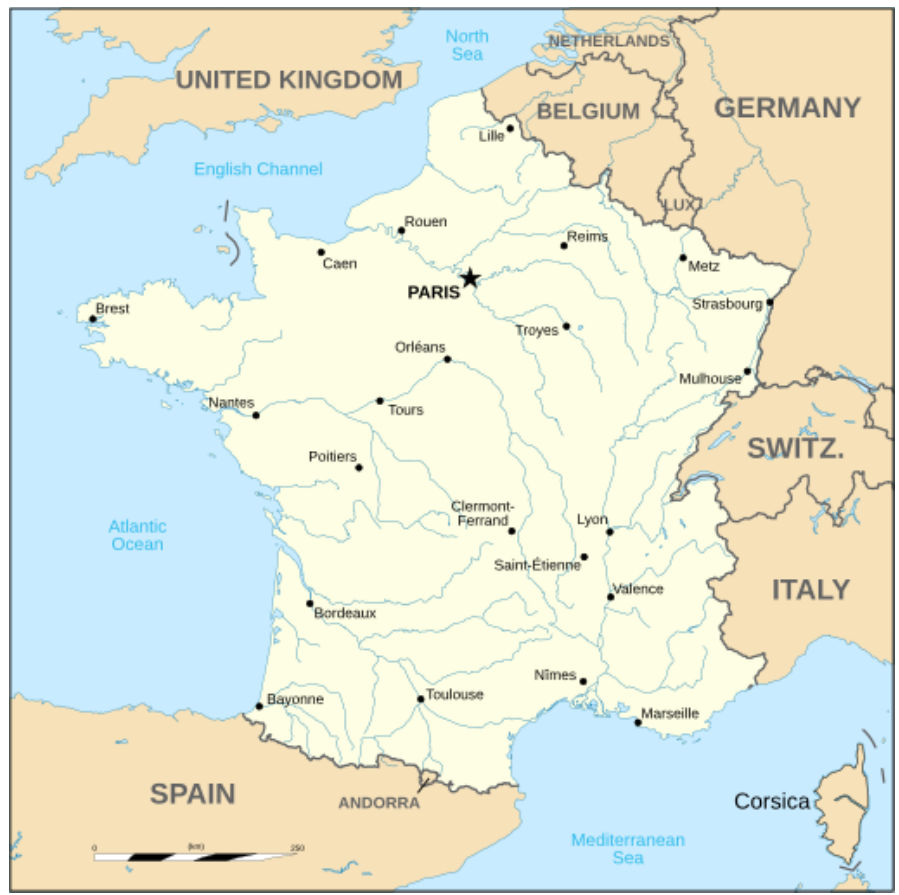
Figure 1. Study area, metropolitan France not including Corsica. Adapted from Wikimedia Commons (original map by Delphi234) CC BY-SA 4.0. https://commons.wikimedia.org/w/index.php?